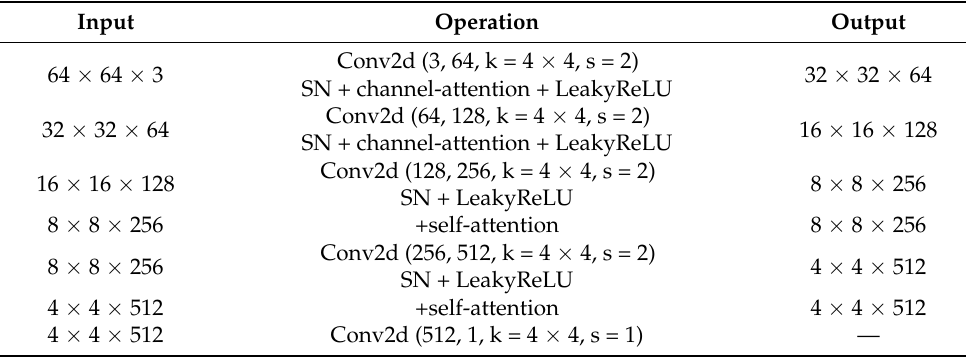
Table 2. The network structure of the discriminator in